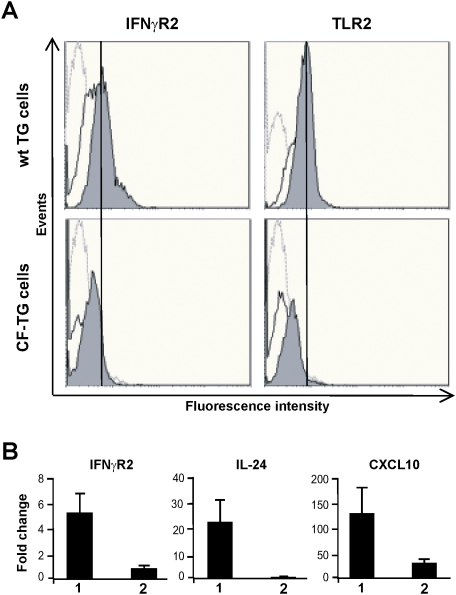
Receptor expression, and effect of IFNγ on gene expression in CF-TG cells.A, wt TG and CF-TG cells were incubated in the absence or presence of P. aeruginosa-secreted products for 24 h. The membrane expression of IFNγR2 and TLR2 was determined by flow cytometry. Histograms are representative of three different experiments. Hatched line, control IgG; Full line, unstimulated cells; Grey color, cells stimulated with P. aeruginosa-secreted products. B, 1000 UI of IFNγ were added to wt TG cells (1) and CF-TG cells (2) for 3 h, and the expression of genes encoding IFNγR2, Il-24 and CXCL10 was studied by qRT-PCR. Results, which represent means±SEM of three experiments, are expressed as fold change. (1) IFNγ-treated vs. untreated wt TG cells; (2) IFNγ-treated vs. untreated CF-TG cells.